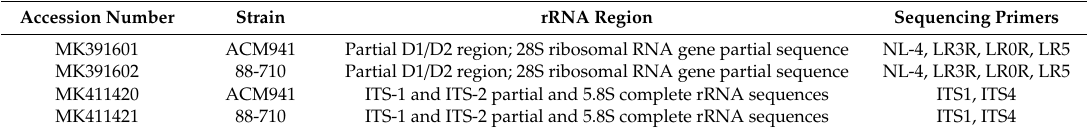
Table3. AccessionnumberofrRNAgenomicregionsamplifiedfrom C.rosea